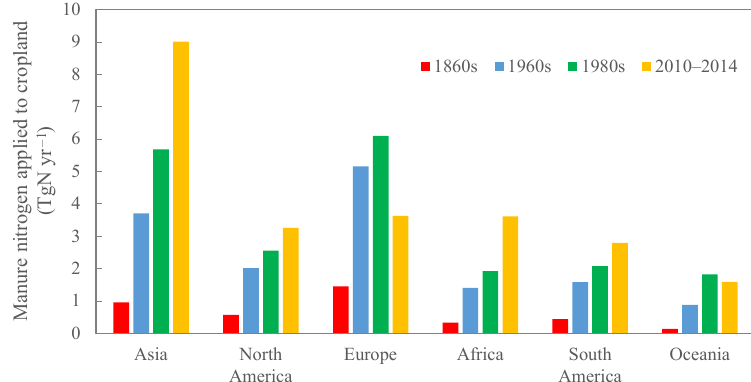
Figure 7. Changes in manure nitrogen amount applied to cropland at the continental level.